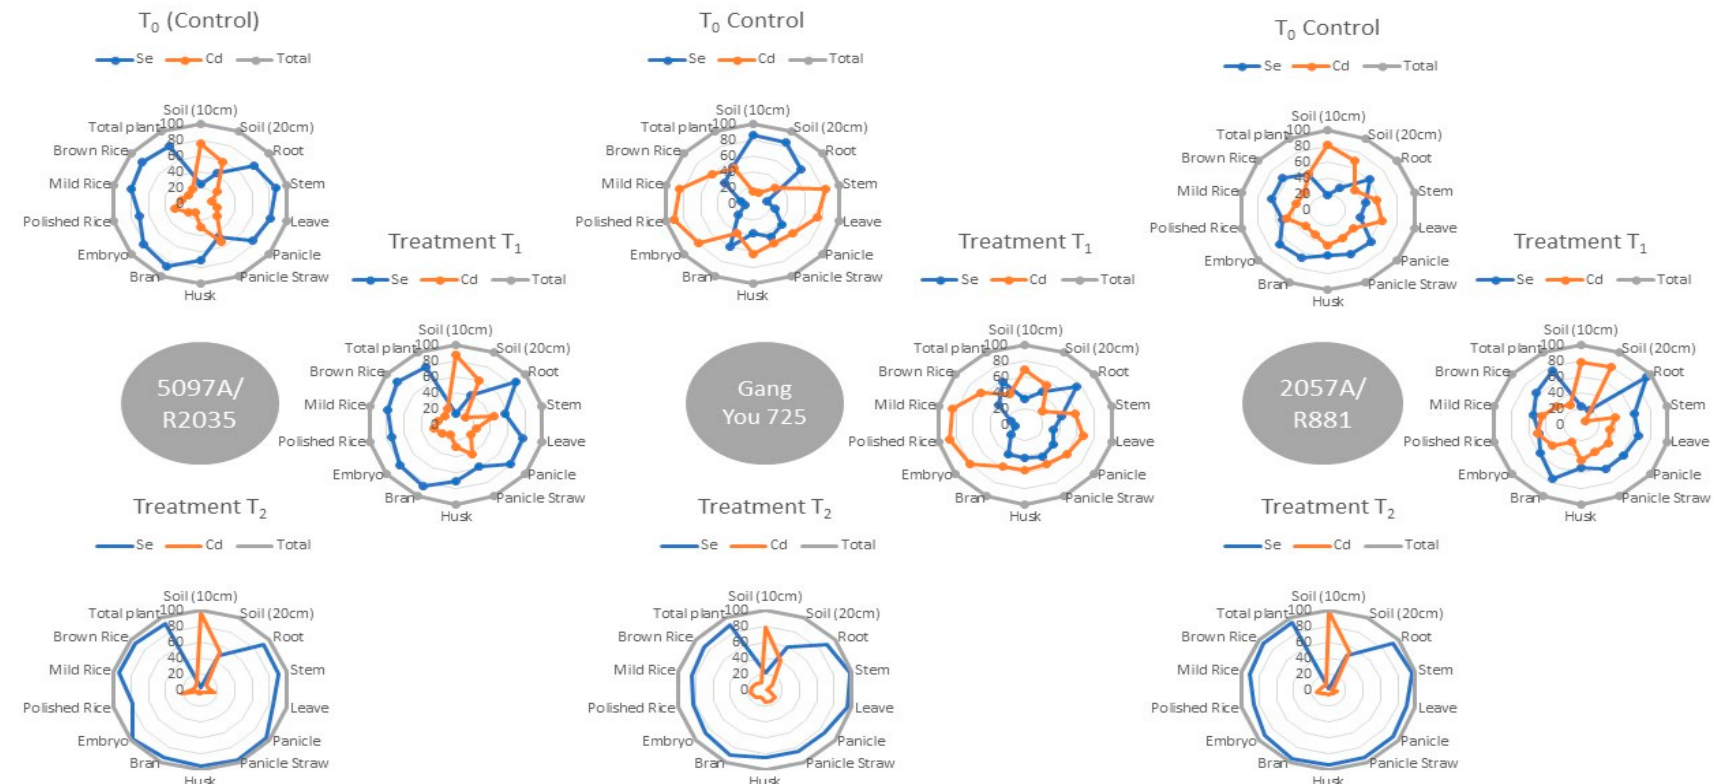
Figure 1. Web diagram indicating the di ff erences between Cd and Se uptake in percentage (three varieties, three treatment levels, di ff erent plant parts). Note: T 0 Control (natural soil conditions), T 1 (Se; 0.4 mgkg − 1 , Cd; 1 mgkg − 1 ), T 2 (Se; 1 mgkg − 1 , Cd; 2 mgkg − 1 ). 5097A / R2035: natural high Se-rich rice, GangYou 725; natural non-Se rich rice, 2057A / R881: natural moderate Se-rich rice.